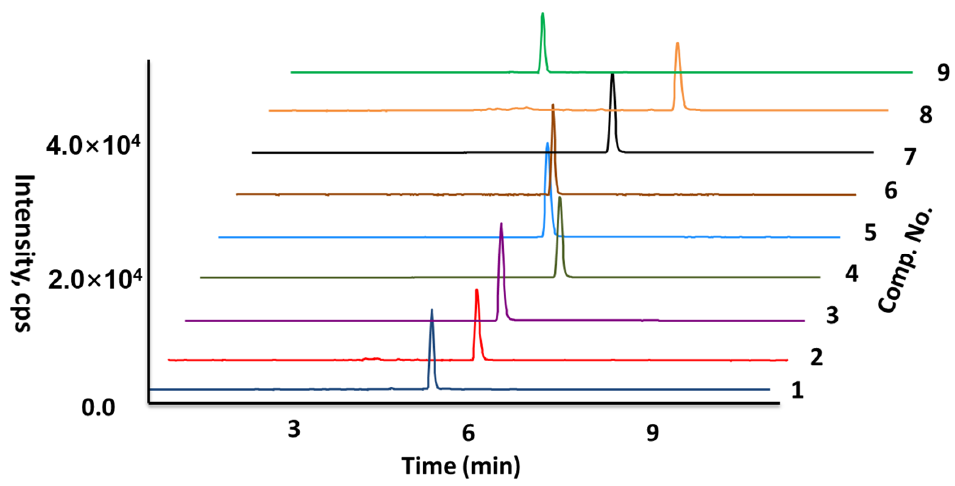
Figure 3. The extracted ion chromatogram of the nine diterpenoids. Table 1. Compound-dependent parameters and monitored ion pairs for nine diterpenoids in the multiple reaction monitoring (MRM) mode for UHPLC–MS analysis.